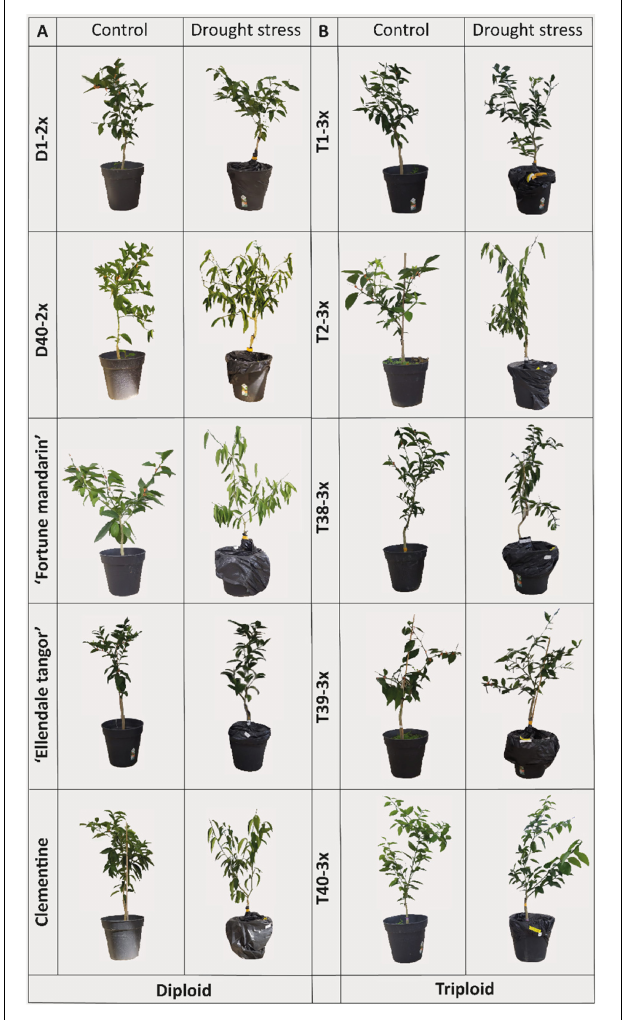
between 0.75 and 0.70 among the varieties, under water